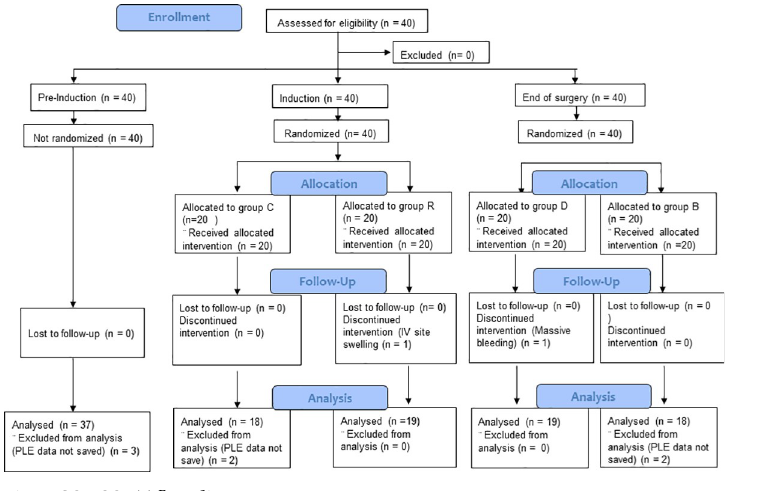
Fig 1. CONSORT flow